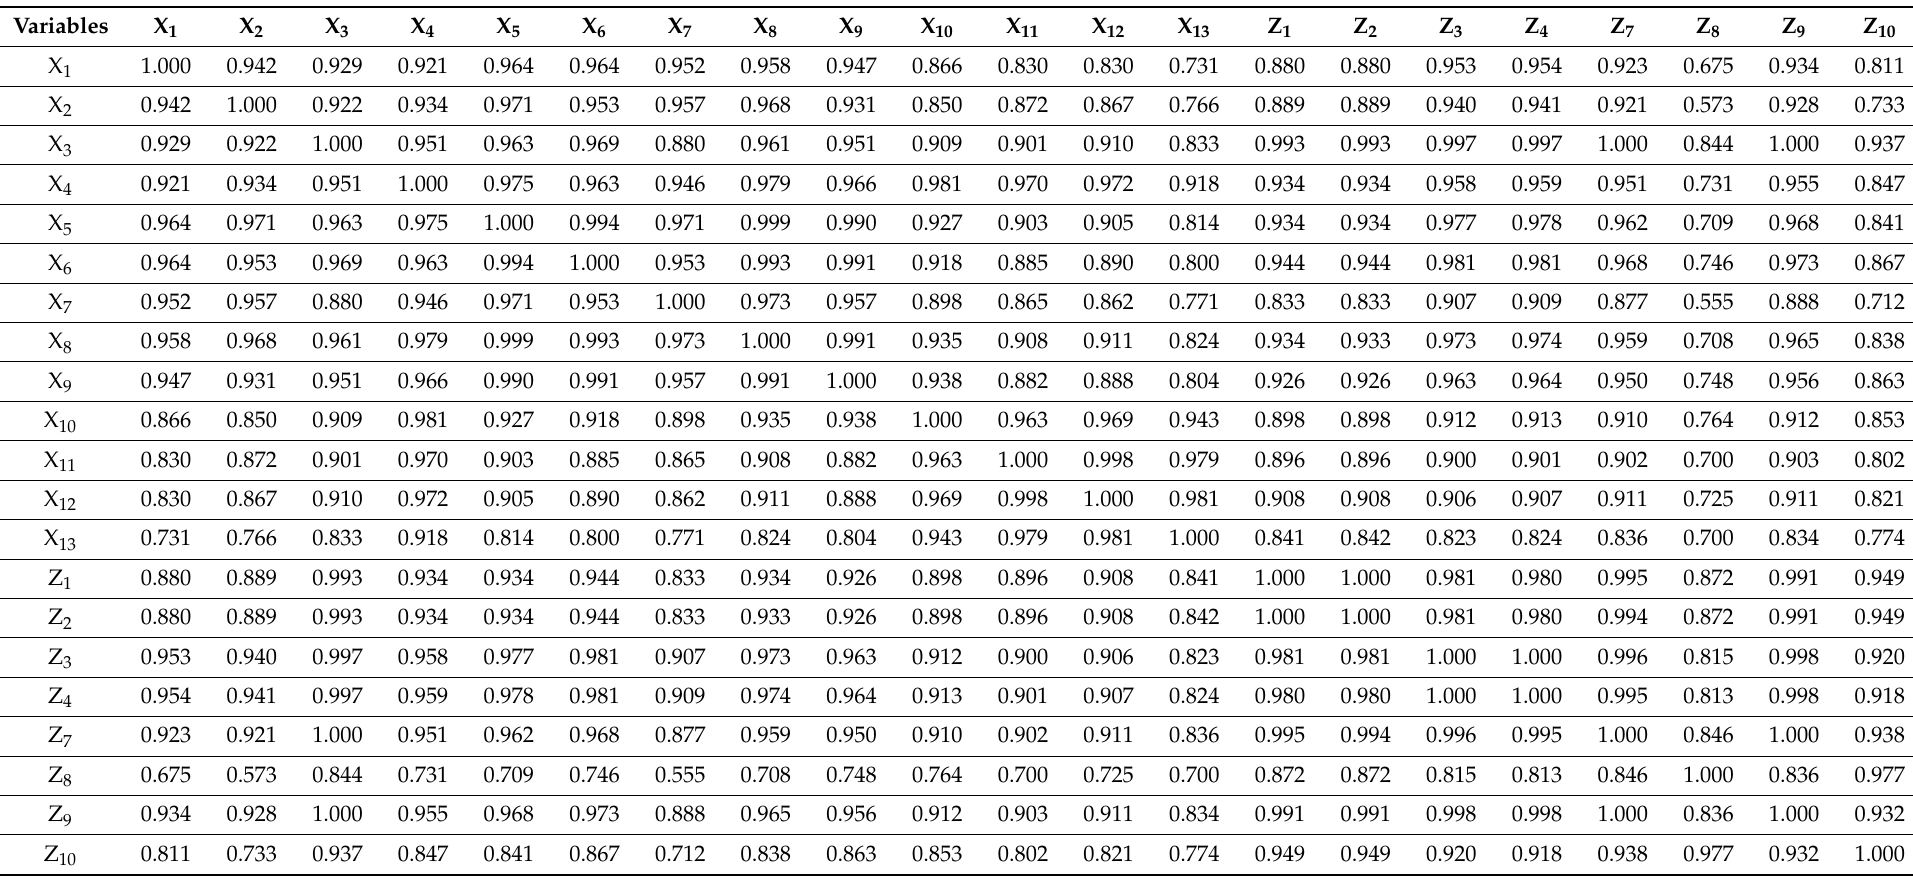
Table A7. Correlation matrix of variables describing milk production